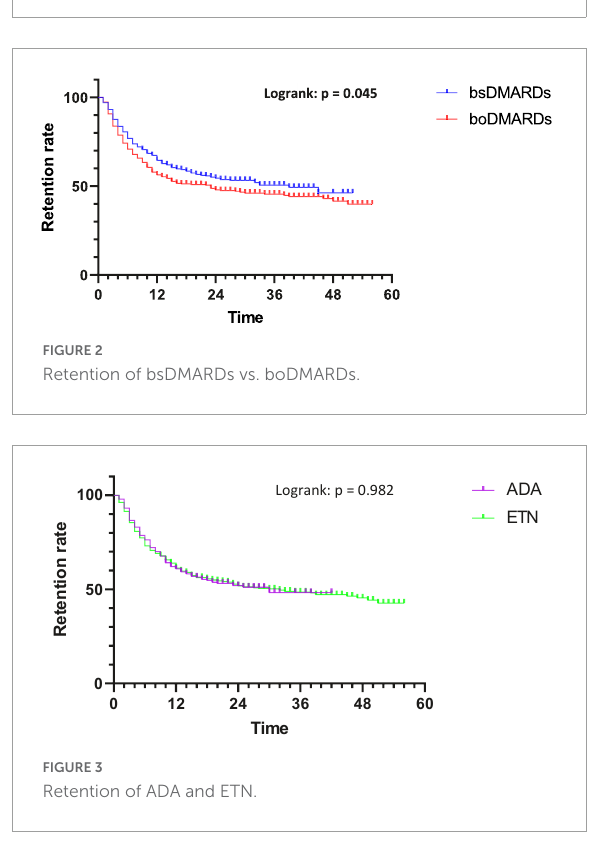
FIGURE3 Retention of ADA and